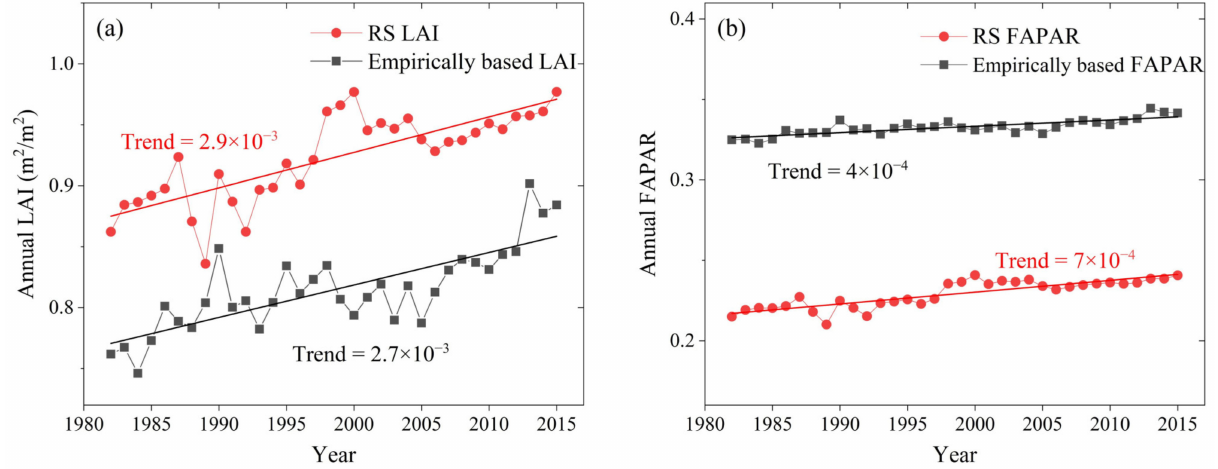
Figure 4. The interannual changes in national-scale LAI ( a ) and FAPAR ( b ) estimated by empirical methods and RS (GLASS) products from 1982 to